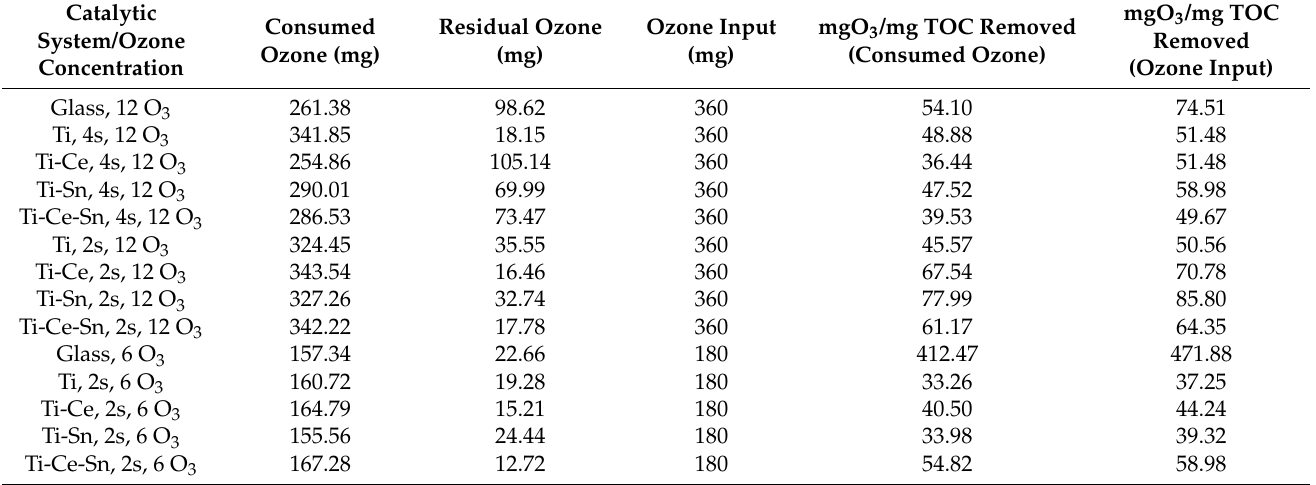
Table 3. Ozone consumption during the oxidation process for prepared thin films in different